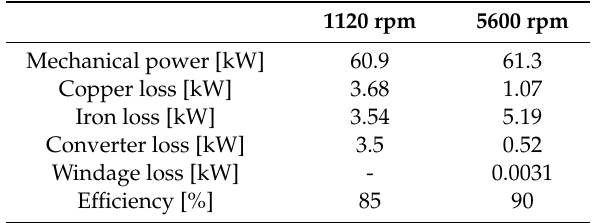
Table 5. OBOLAR Fly SR machine and drive losses and efficiencies.